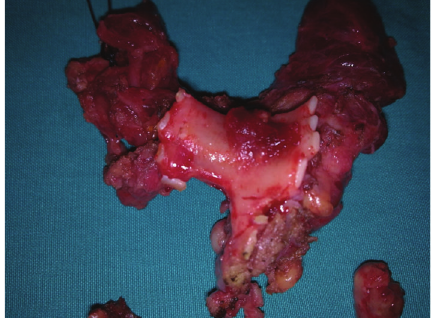
Figure 2: Macroscopic appearance of the mass along with the corresponding anterior portions of three tracheal